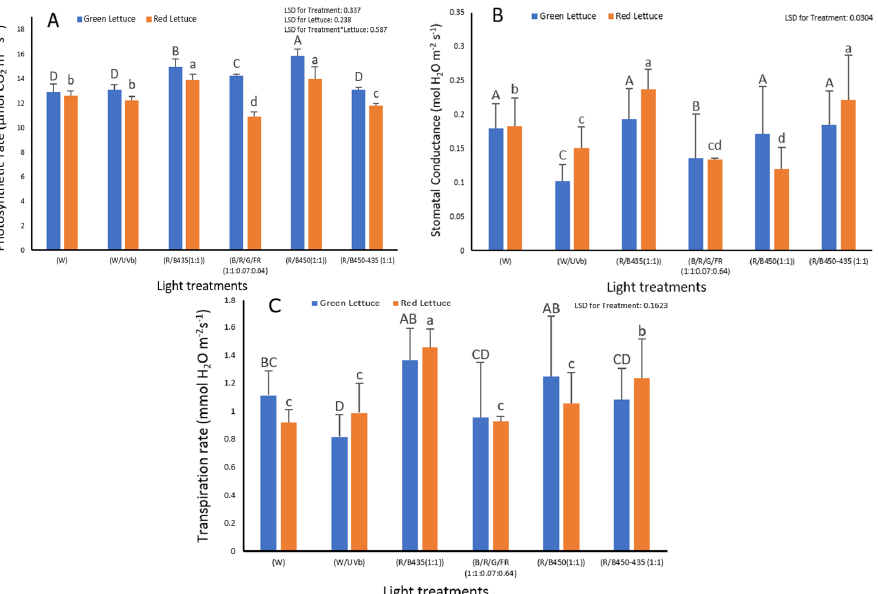
Figure 4. The impact of LED light spectrum on ( A ) photosynthetic rate (µmol CO 2 m −2 s −1 ); B) stomatal conductance (mol H 2 O m −2 s −1 ); ( C ) transpiration rate (mmol H 2 O m −2 s −1 ) of green lettuce (Locarno variety) Carmoli variety (red lettuce). Letters indicate significant differences ( p < 0.05) between treatments in each experiment. (Capital letters are for green lettuce and small letters are for red lettuce.)